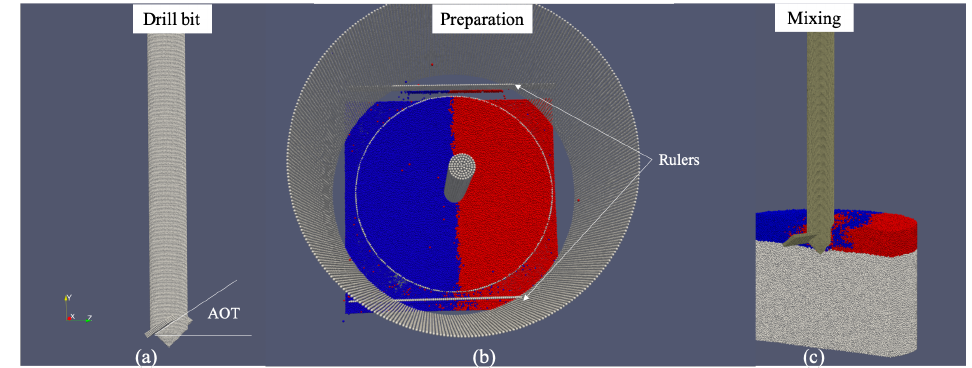
Figure 3. ( a ) mixer head in DEM simulation, the angle of attack (AOT) for validation was fixed at 35 ◦ as in the experiment; ( b ) in the preparation phase, the initial filling height of color sand was controlled to be as the same in the experiments; ( c ) a screenshot during the mixing phase in DEM simulation (for a better view, the mixer head and half of the particles shown without the cylindrical